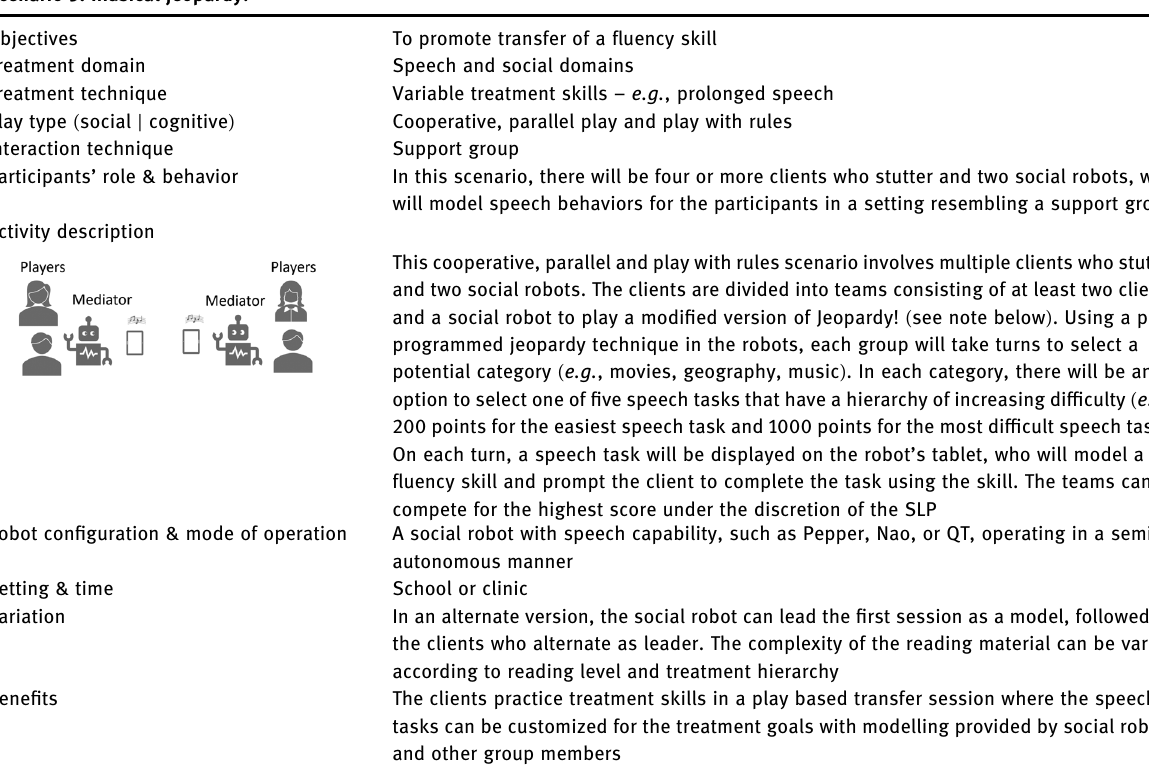
Table 5: Description of scenario 5 Scenario 5: Musical